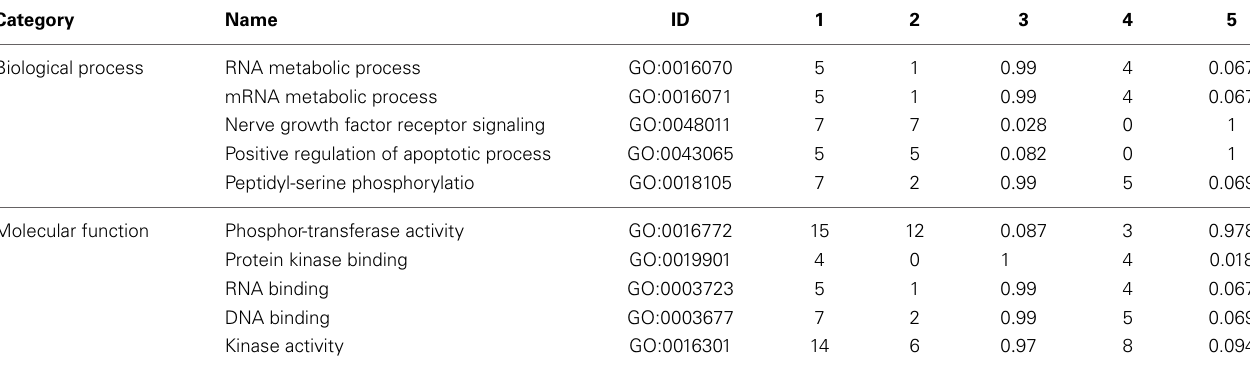
Table 4 | Gene ontology analysis of resistant dark-eyed pupae (S88 + /S88 − ). Category